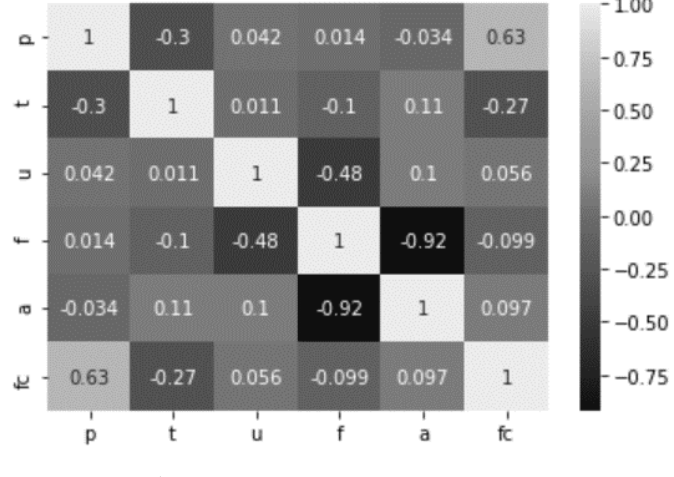
Figure 4. Correlation Heatmap.